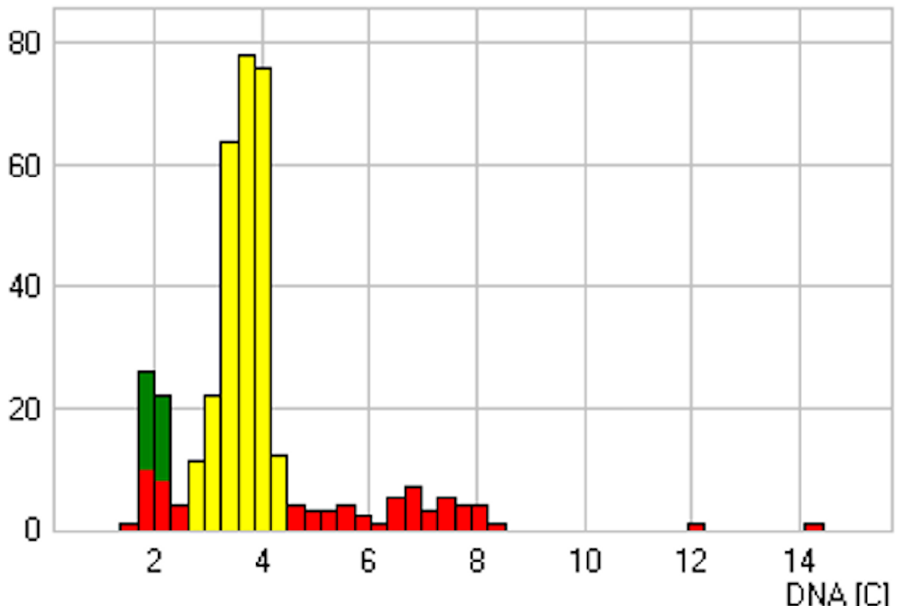
Figure 3. Sample with a suspicious cytological diagnosis and presence of DNA aneuploidy as a sign of malignant transformation. An atypical stemline at 3.52c is shown with an associated doubling peak and two cells with a DNA content >9c. DNA content in c-units ( x -axis), number of cells ( y -axis), reference cells (green), analysis cells (red), biggest stemline (yellow). In the follow-up of this sample, a second carcinoma of the floor of the mouth was diagnosed in an 86-year-old male patient.